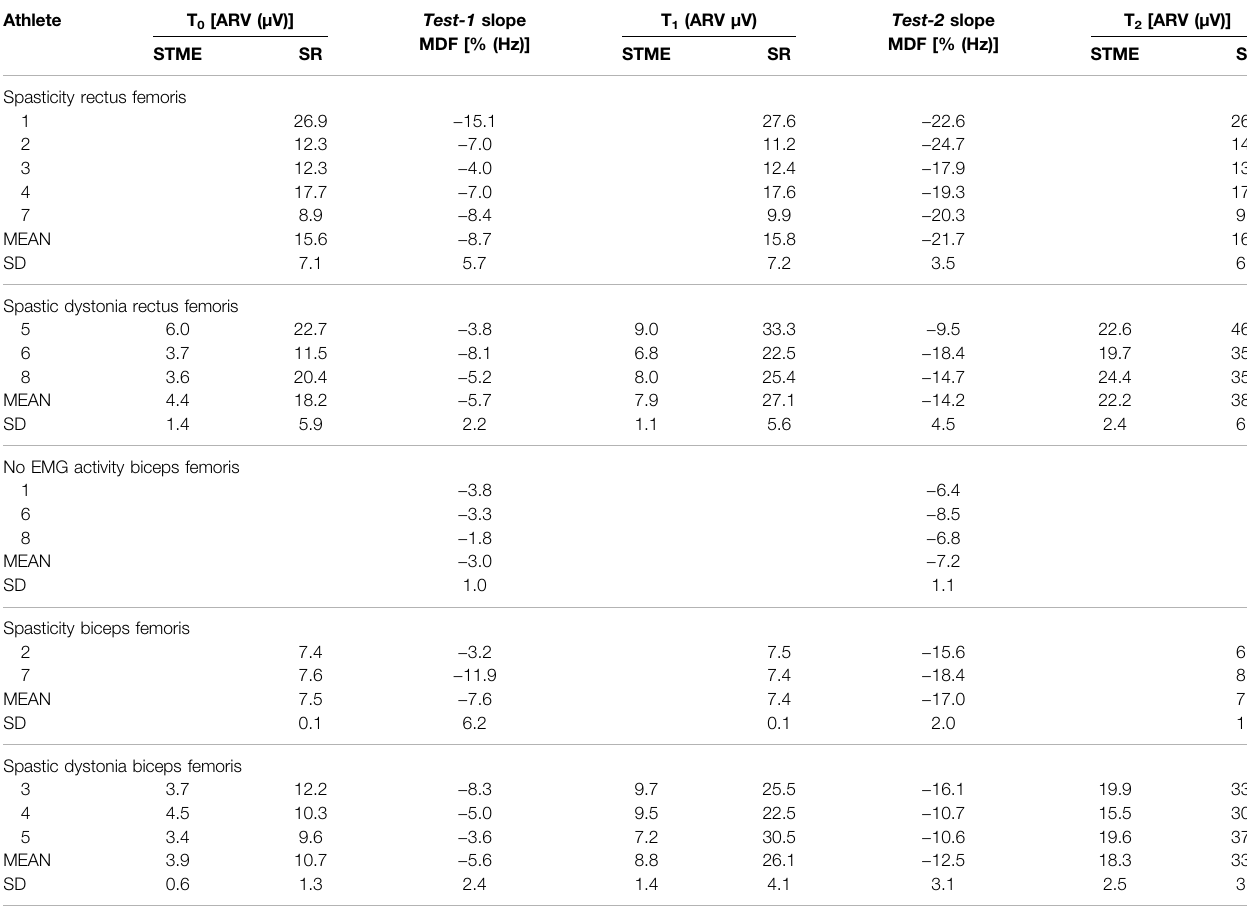
TABLE 3 | Average recti fi edvalue (ARV) ofspontaneoustonic muscleexcitation(STME) and stretch re fl exalongthe three time points (T 0 , T 1 and T 2 ).Slope values ofmedian frequency (MDF) regression line along the 15 ( test-1 ) and 35 ( test-2 ) fl exion movements. Athlete T 0 [ARV ( μ V)]